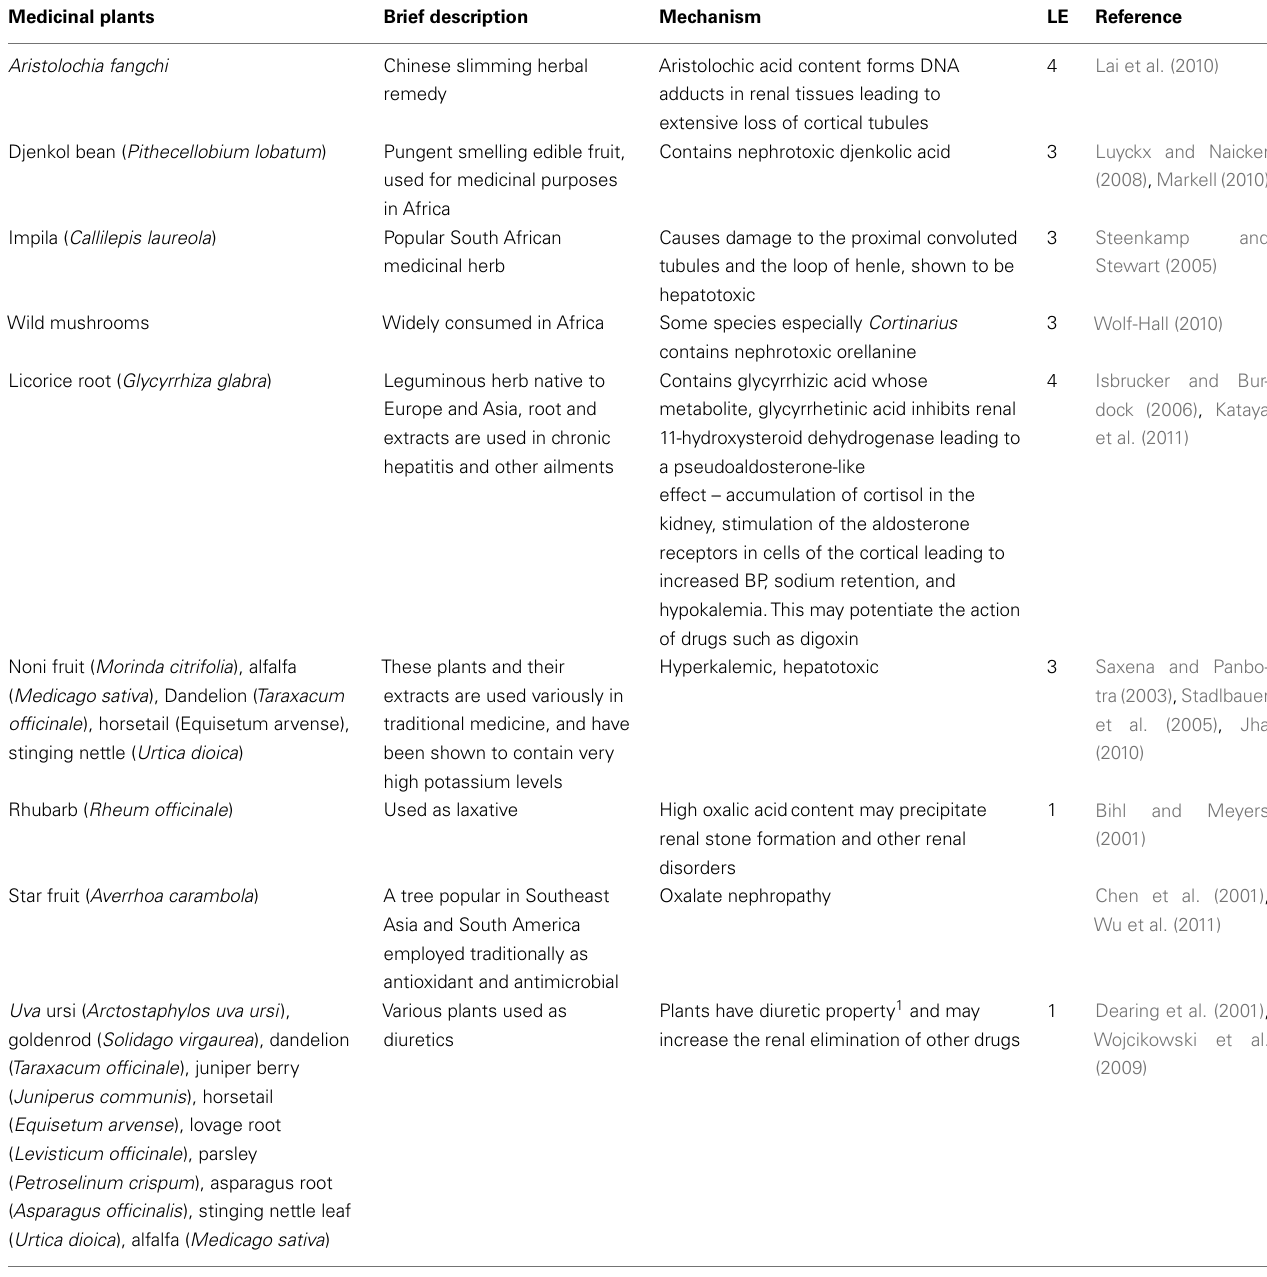
Table 5 | Some herbal remedies capable of interacting with other drugs via alteration in renal functions. Medicinal